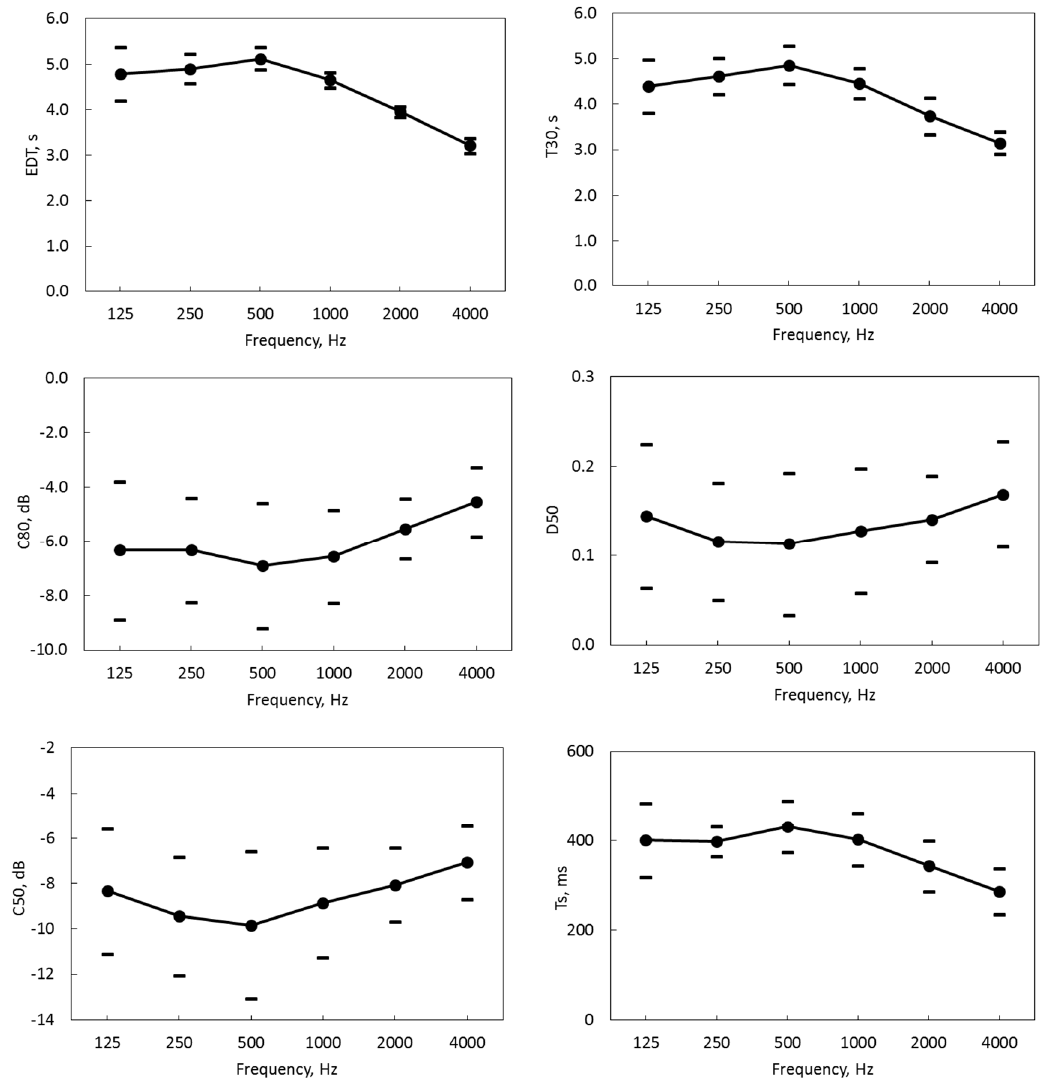
Figure 5. Measured acoustics parameters averaged among the 15 receiver positions, and relative standard deviations.